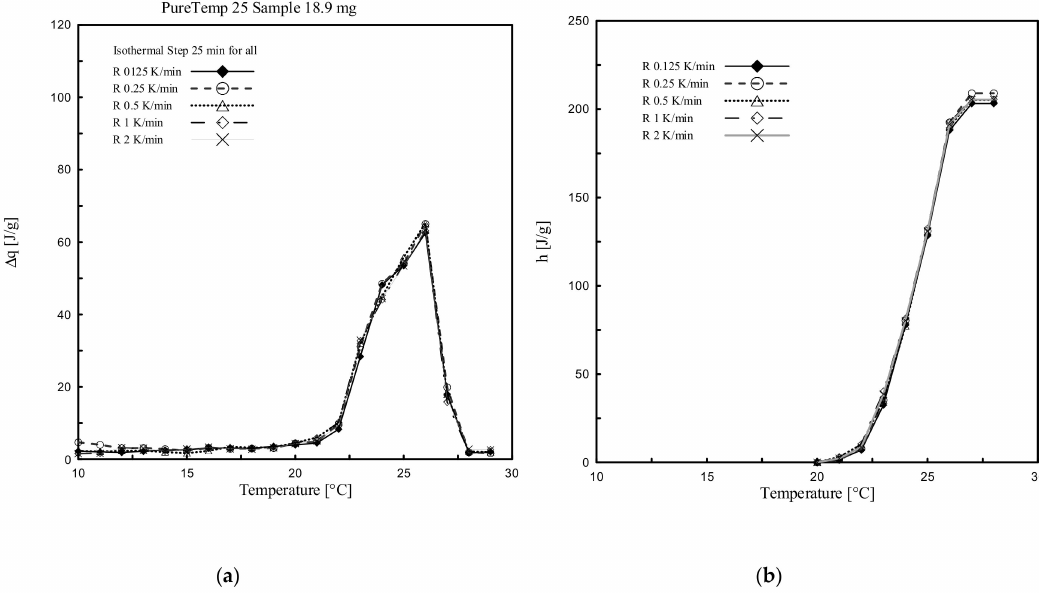
Figure 16. ( a ) ∆ q (T) and ( b ) h(T) curves determined through stepwise DSC and considering di ff erent heating rates for